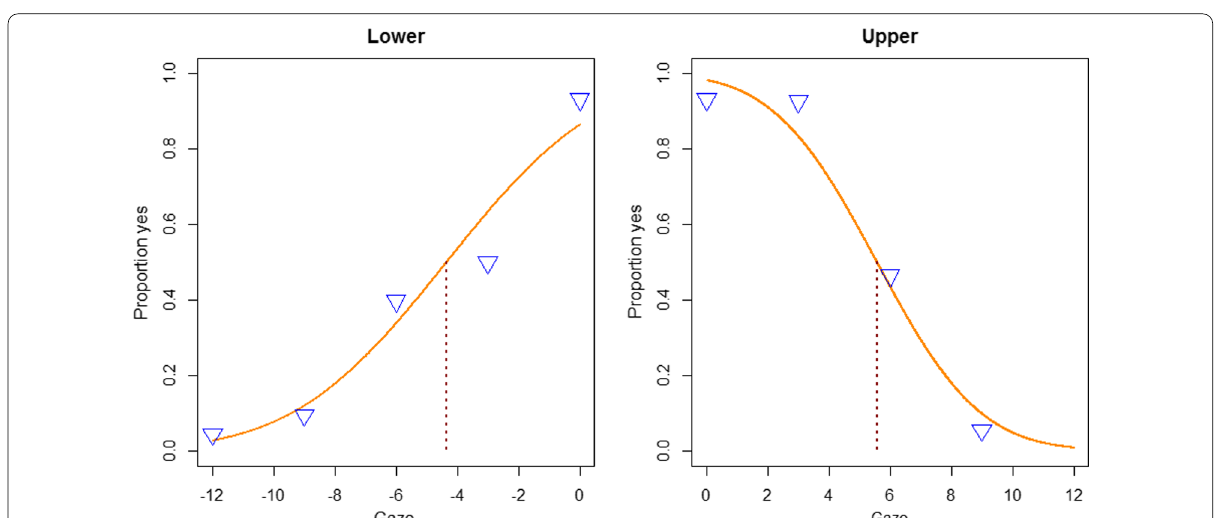
Fig. 4 Separate fittings of the lower and the upper half with cumulative Gaussians, with measurements collapsed over the factors size and